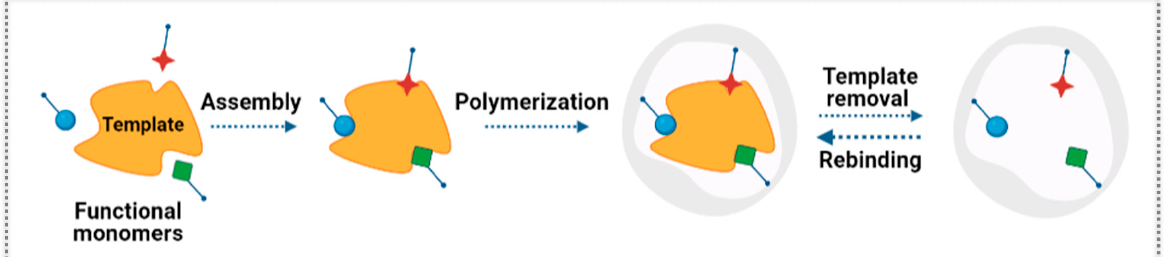
Figure 7. Scheme of the principle of molecular imprinting recognition.